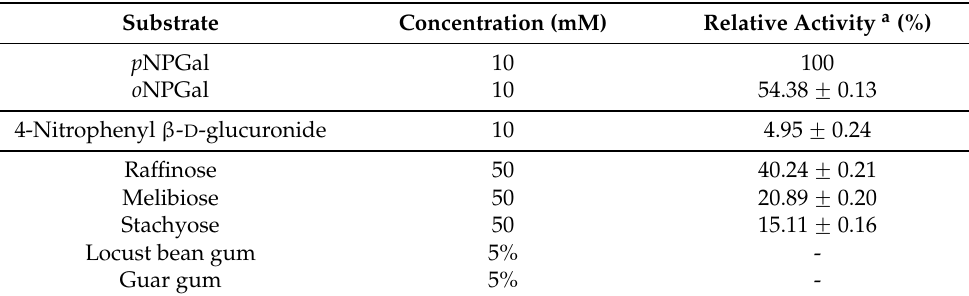
Table 3. Hydrolysis of substrates by